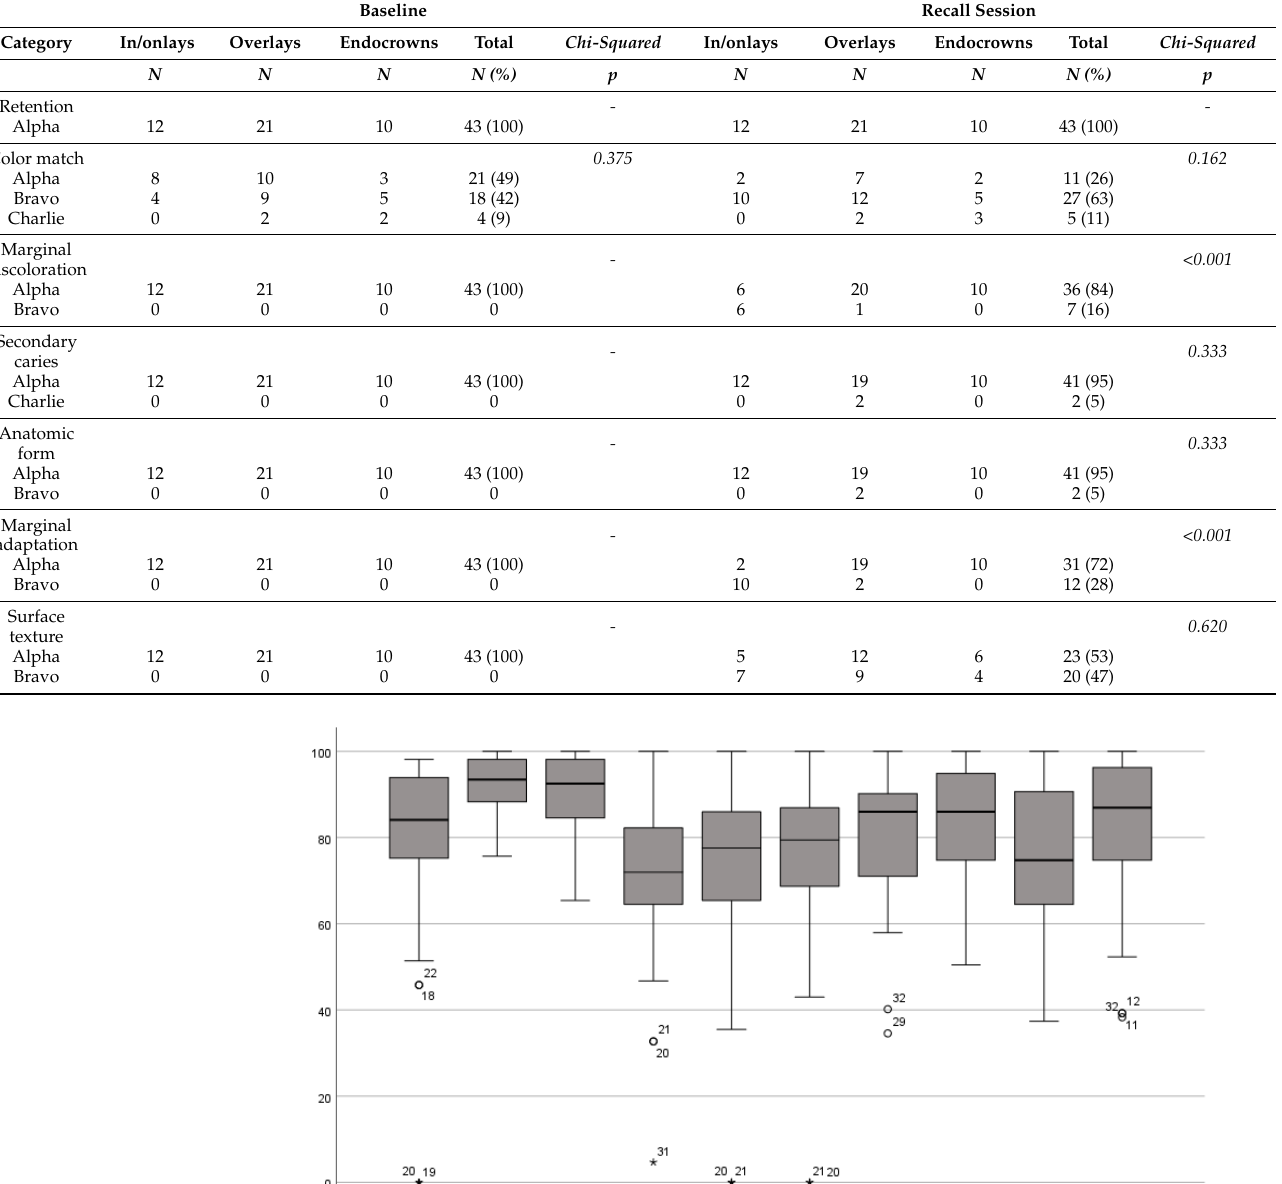
Table 5. USPHS scores and Chi-Square statistics at baseline and endpoint per restoration type. Baseline